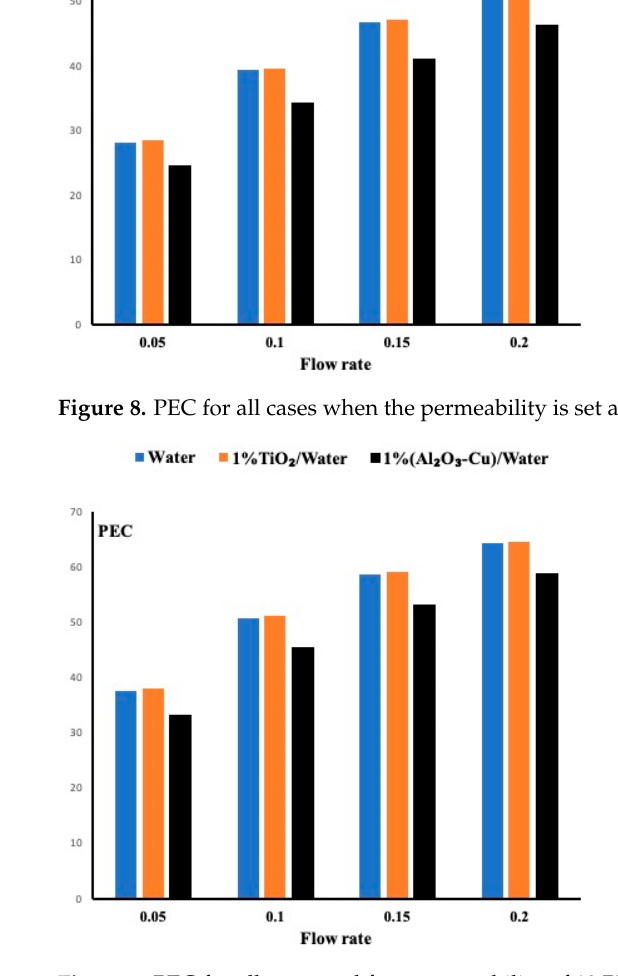
Figure 9. PEC for all cases and for a permeability of 10 PPI.